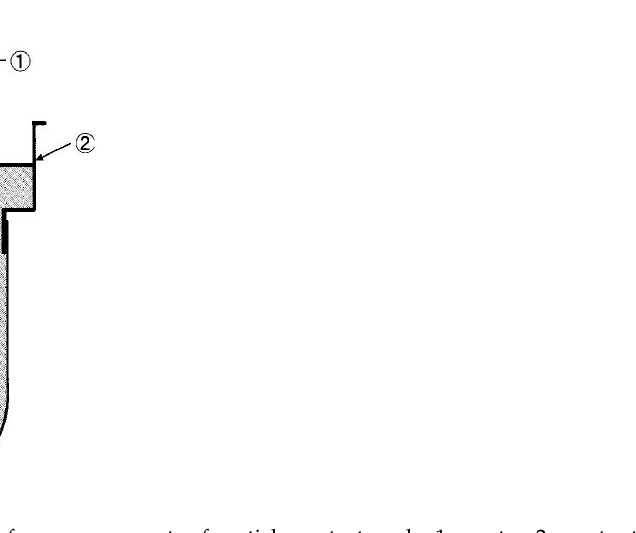
Figure A1. Experimental setup for measurements of particle contact angle: 1—water; 2—water tank; 3—rubber tube; 4—cotton; 5—particles; 6—glass tube.